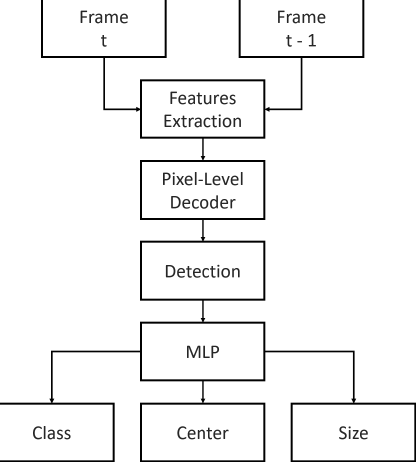
Figure 6. P3AFormer system overview [57]. The current and previous frames are passed for features extraction and detection. The extraction module consists of a backbone network, pixel-level decoder, and a detector, which is illustrated on the right. The features are passed to MLP heads to output the class, center, and size